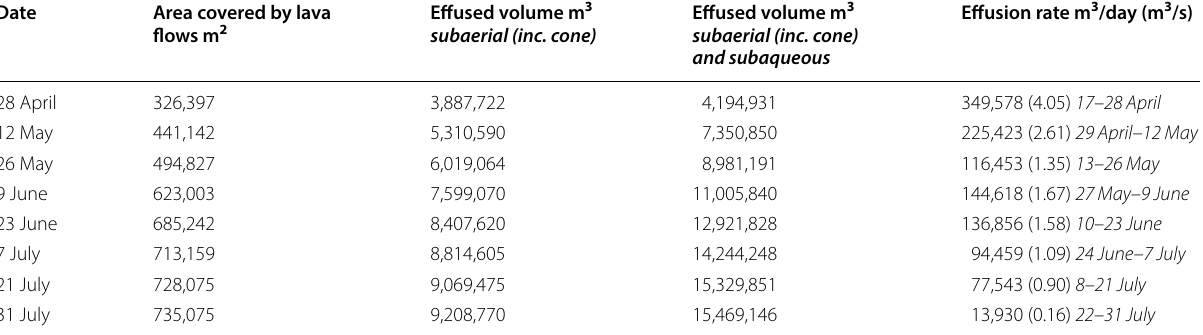
Table 1 Effused volume and effusion rate for the 2017 Nishinoshima eruption based on analysis of the ALOS-2